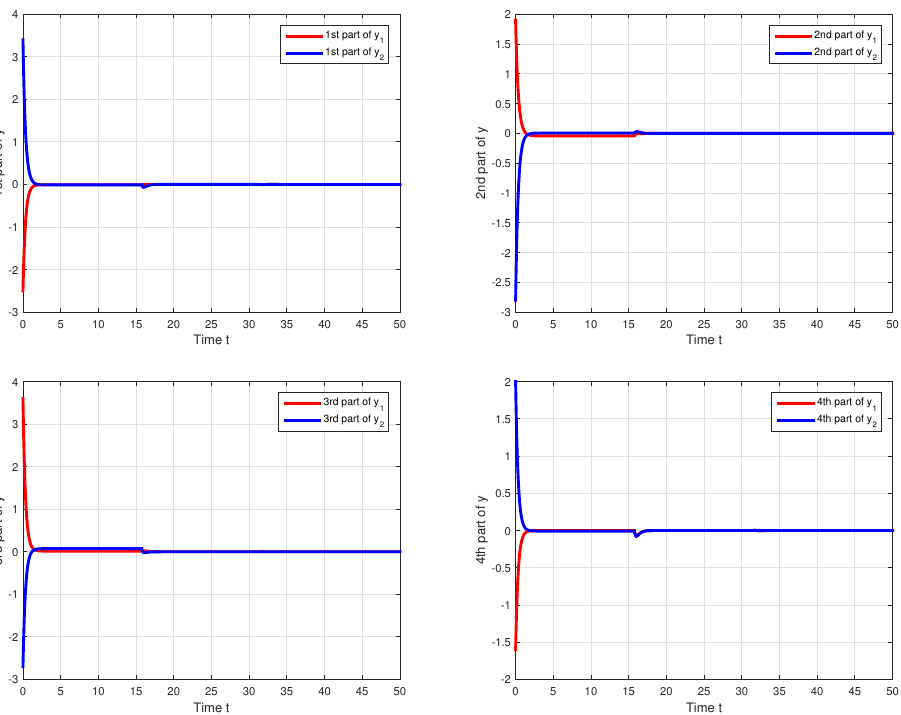
Figure 2. The four parts of the state trajectories for the QVNTNNs (Equation (1)) in Example